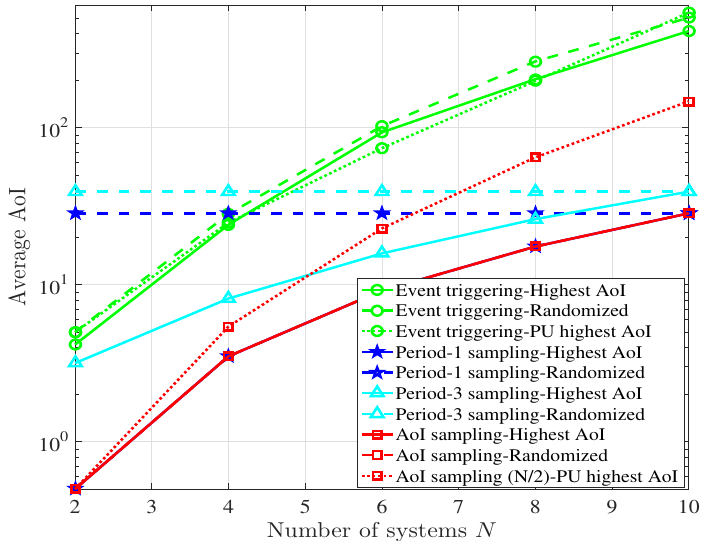
Figure 7. Average AoI achieved under different